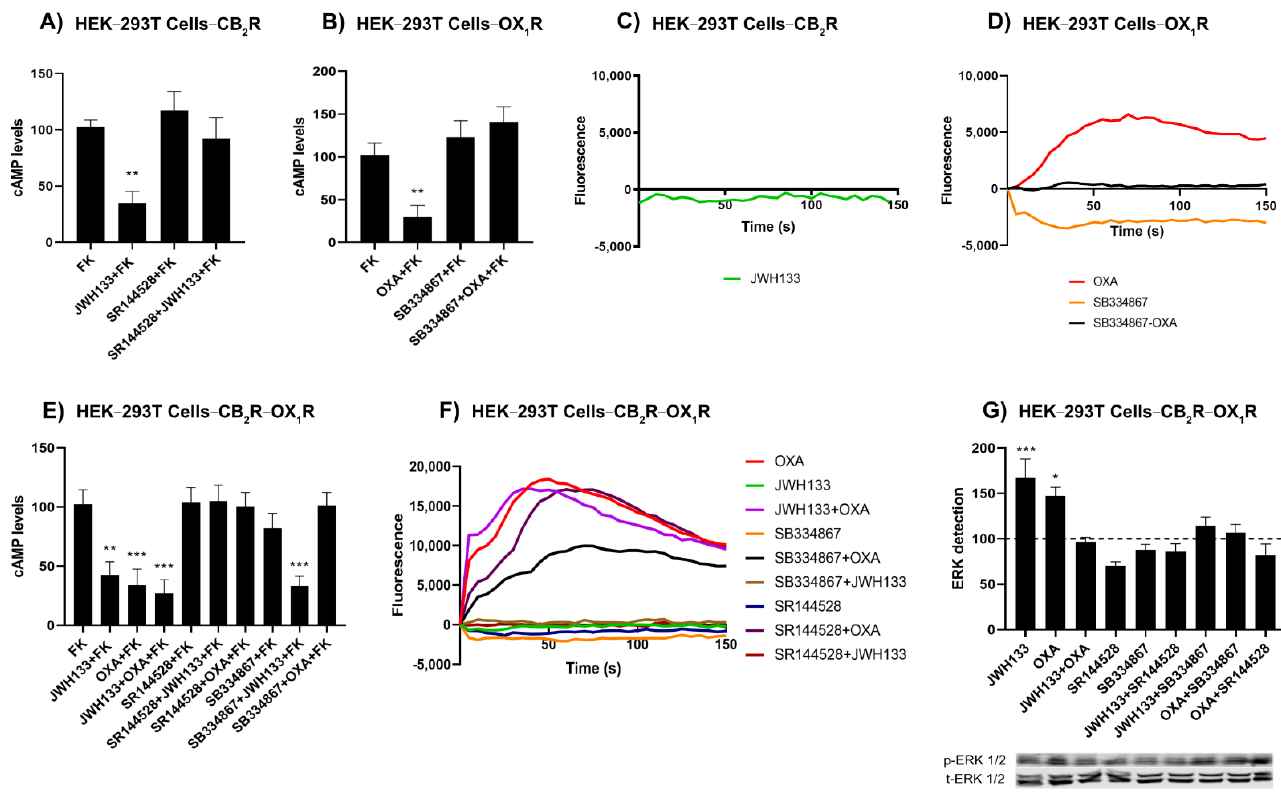
Figure 2. Functionality of OX 1 R-CB 2 R heteromer in HEK-293T cells. ( A , B , E ) HEK-293T cells were transfected with the cDNA for the CB 2 receptor (1 µ g) ( A ), for the OX 1 receptor (1 µ g) ( B ) or both ( E ) and were pretreated with selective receptor antagonists (1 µ M SB334867 for OX 1 R or 1 µ M SR144528 for CB 2 R) or vehicle and treated with selective agonists (100 µ M Orexin-A for OX 1 R and/or 100 nM JWH133 for CB 2 R) followed by 0.5 µ M forskolin stimulation (15 min). Values are the mean ± S.E.M. of six independent experiments performed in triplicates. One-way ANOVA followed by Bonferroni’s multiple comparison post hoc test were used for statistical analysis ( ** p < 0.01, *** p < 0.001) versus FK condition. ( C , D , F ) HEK-293T cells were transfected with the cDNA for the GCaMP6 calcium sensor (1 µ g) and for the CB 2 receptor (1 µ g) ( C ), for the OX 1 receptor (1 µ g) ( D ) or both receptors ( F ). Receptors were activated using selective agonists (100 nM orexin-A for OX 1 R and/or 100 nM JWH133 for CB 2 R). When indicated, cells were pretreated with selective antagonists (1 µ M SB334867 for OX 1 R or 1 µ M SR144528 for CB 2 R). Cytosolic calcium readings were collected and data are the mean ± S.E.M. from six independent experiments. ( G ) ERK1/2 phosphorylation was determined in HEK-293T cells expressing the CB 2 receptor (1 µ g cDNA) and the OX 1 receptor (1 µ g cDNA). Results are expressed in percentage with respect to basal condition. Values are the mean ± S.E.M. of five independent experiments performed in triplicates. A resentative Western blot is shown (bottom). p-ERK1/2: phosphorylated ERKs; t-ERK1/2: total ERKs. * p < 0.05, *** p < 0.001. One-way ANOVA followed by Bonferroni’s multiple comparison post hoc test were used for statistical analysis * p < 0.05 versus basal condition in ERK1/2 phospohorylation assays or versus FK condition in cAMP determination assays (dashed